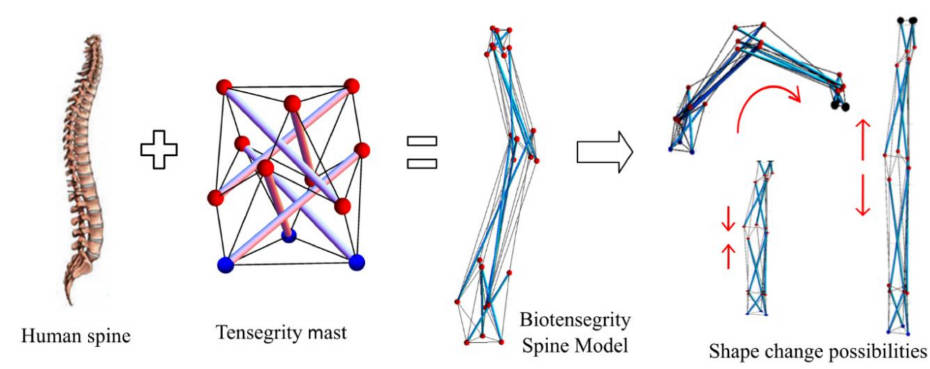
Figure 1. Motivation of the